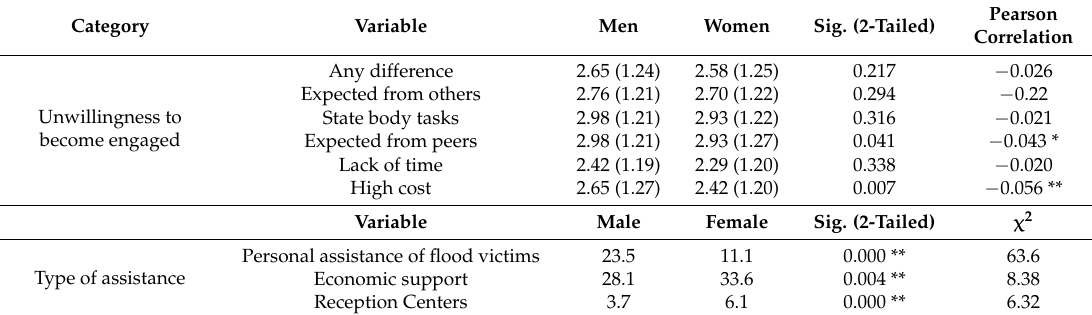
Table 9. Pearson correlation and Chi-square test results between assistance and gender. Likert scales mean are shown and standard deviations are presented in parenthesis for the first set of variables.